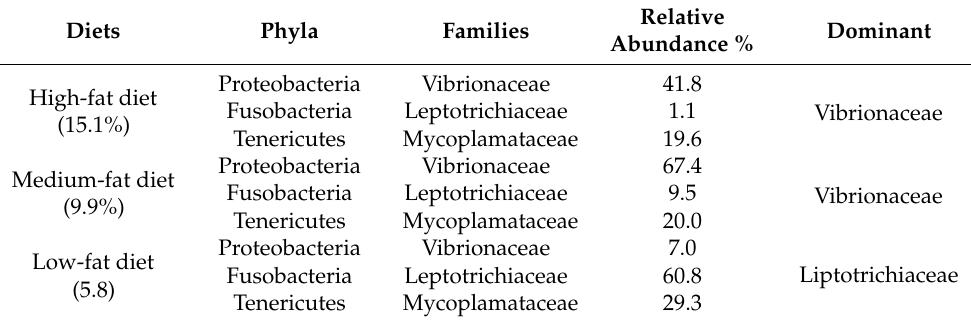
Table 2. Dietary lipid level shaping GI tract microbial communities